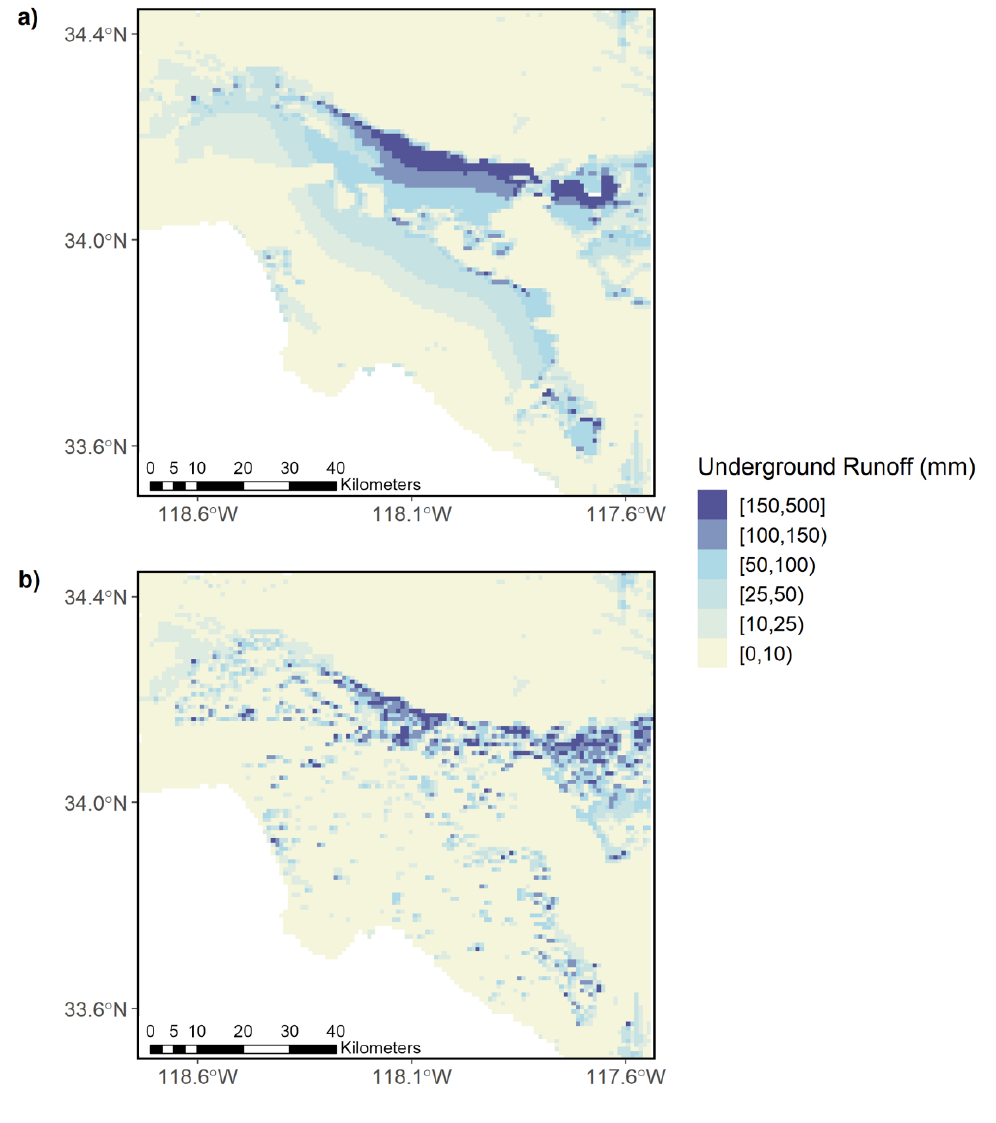
Figure 11. Accumulated water flow out of the bottom LSM soil layer as deep drainage (or “under- ground runoff”) in the LA metropolitan area over the December 2010 precipitation event for ( a ) the pre-urban development scenario without impervious surfaces and ( b ) the post-urban development scenario under present imperviousness conditions.